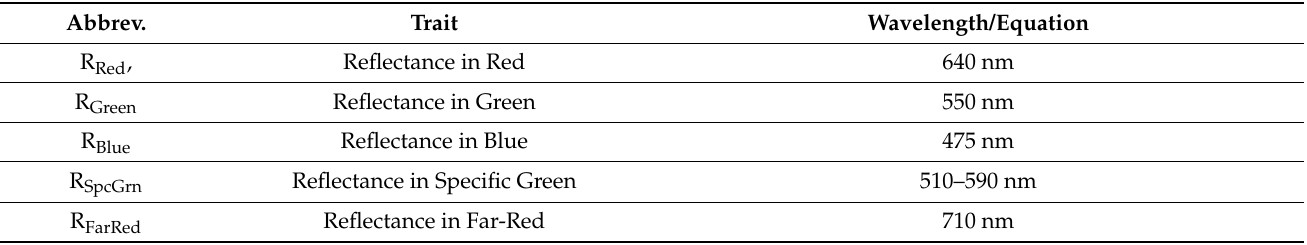
Table 2. List of analyzed multispectral parameters with abbreviations, wavelength for measurement or equation for calculation, and the reference if